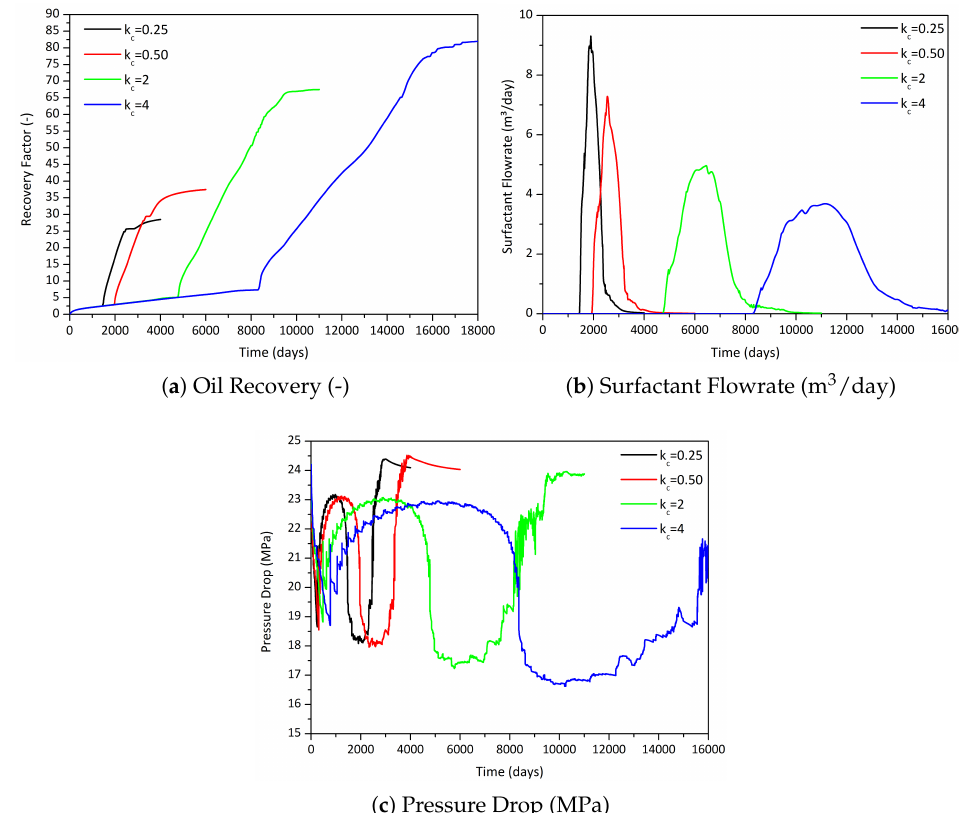
Figure 7. Oil recovered ( a ), total surfactant flowrates ( b ), and pressure drop ( c ) as a function of time for different partition coefficients in a surfactant